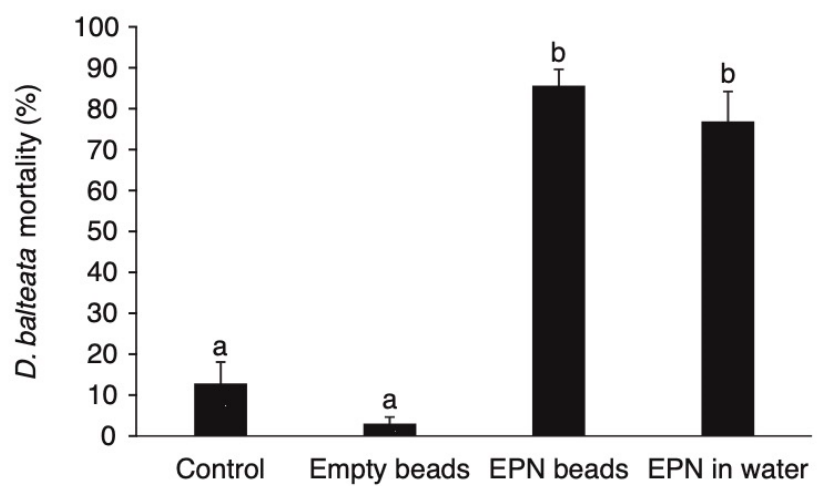
Figure 1. Mortality of D. balteata larvae following application of H. bacteriophora in aqueous suspension or in alginate beads. Bars represent mean percentage ± SE. Means denoted by different letters are significantly different ( p < 0.05).